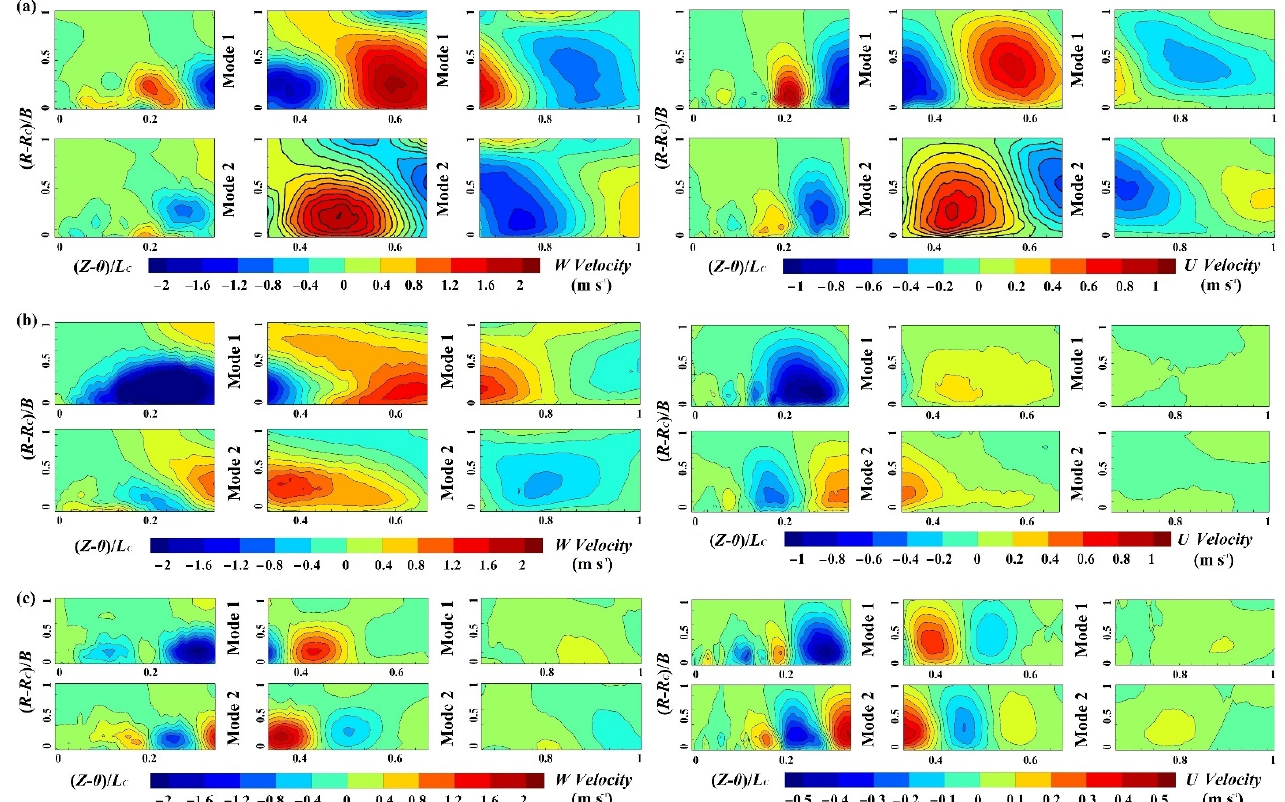
Figure 5. Large-scale coherent vortices of the first and second modes at Q = 40 (m 3 h − 1 ): ( a ) contour of structures of velocity at η = 0.6; ( b ) contour of structures of velocity at η = 0.7; ( c ) structures of velocity at η = 0.8.